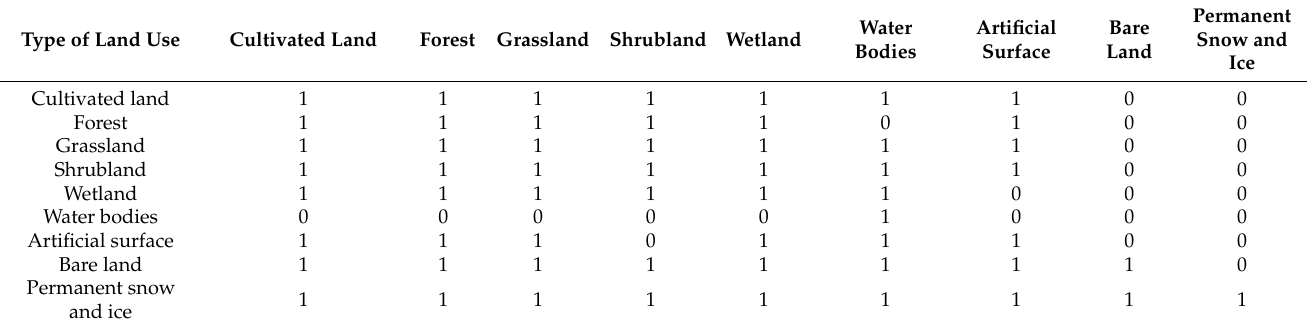
Table 2. Parameters of the conversion matrix under the three scenarios (BAU/UDC/EDP) in the Sichuan-Yunnan Ecological